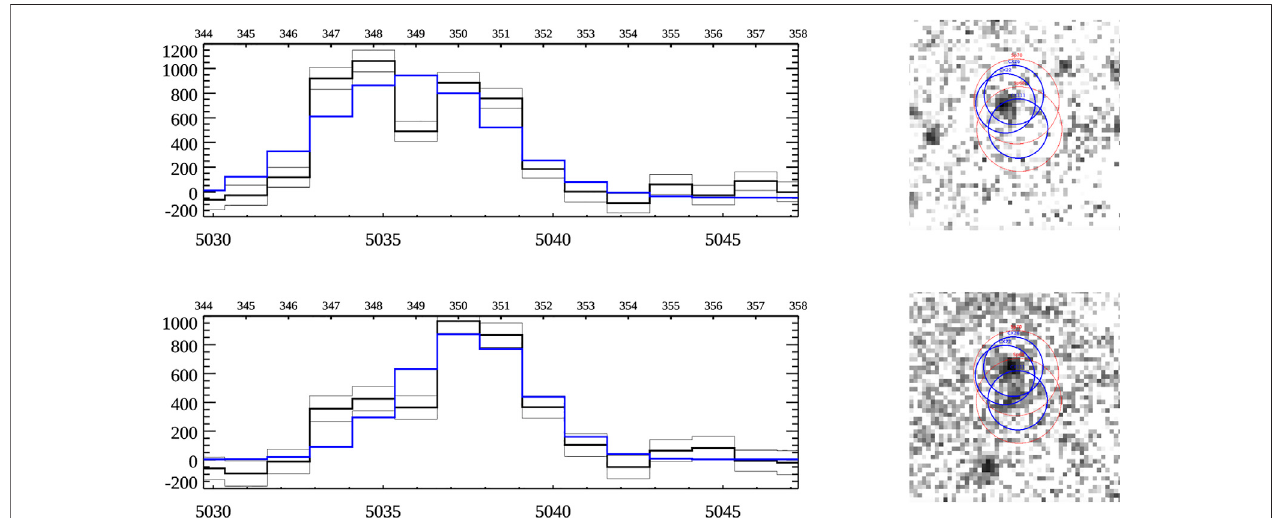
FIGURE 7 | MUSE data of an [O III] source located 0. ′ 3 from the nucleus of NGC1380. The panels on the left display a segment of the source ’ s fi tted spectrum (shown in blue) extracted in two 0. ′′ 6 radius apertures separated by 0. ′′ 55 on the sky; the right panels display two 1.25 Å wide “ images ” of the source, one centered at 5,034.72 Å (top) and the other at 5,037.22 Å (bottom). Careful inspection of the data demonstrates that the [O III] source actually consists of three separate PNe. The deblendedspectraofthePNeareshownastheblackandgreylinesontheleft,andthebest- fi tlocationsoftheindividualPNearedenotedbythebluecirclesonthe right. If the galaxy were more distant, if the seeing were poorer, or the resolution of MUSE were less, the three objects would appear as one “ overluminous ” PNe. From Roth et al.